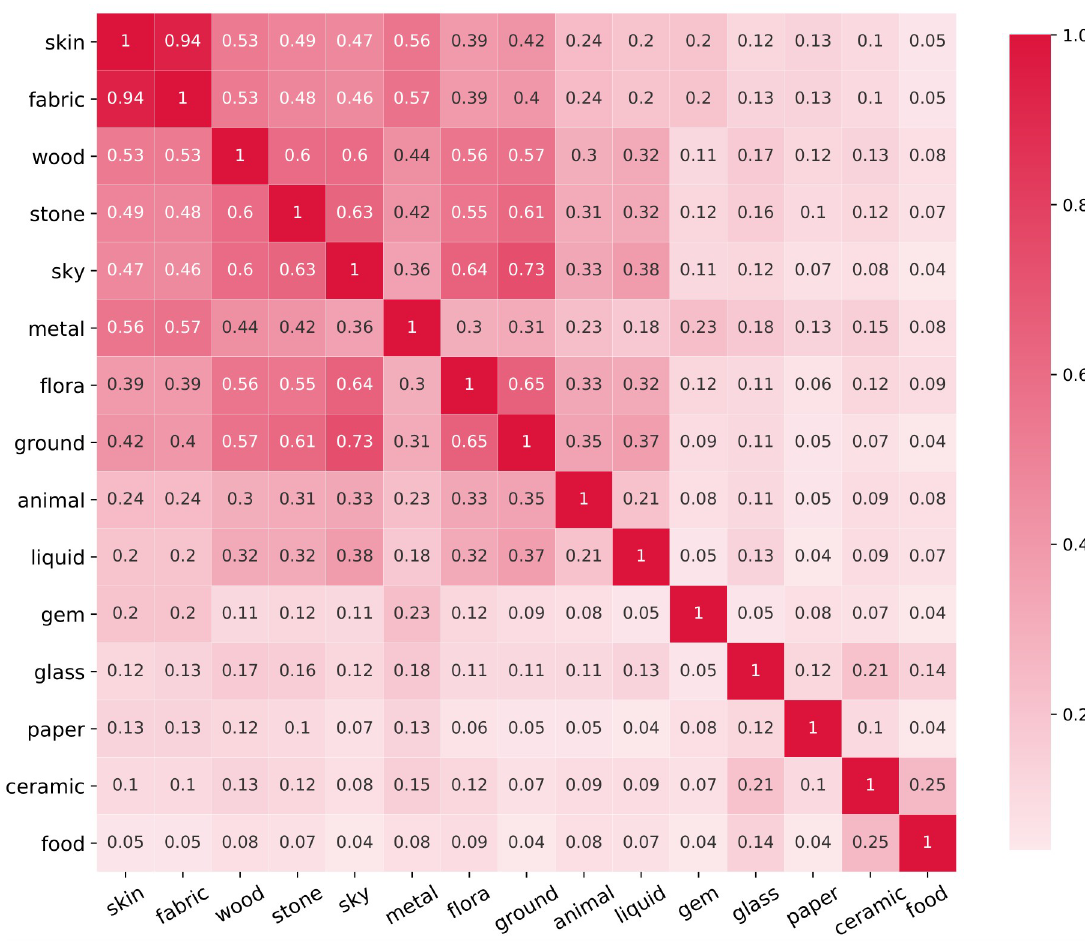
Fig 6. Co-occurrence matrix. Each cell equals the number of paintings where both materials are present divided by the number of paintings where one or the other material is